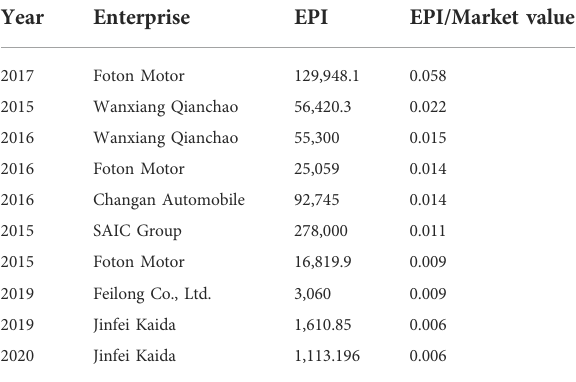
TABLE 11 Ranking of market value ratio of EPI of listed companies in automobile manufacturing industry from 2012 to